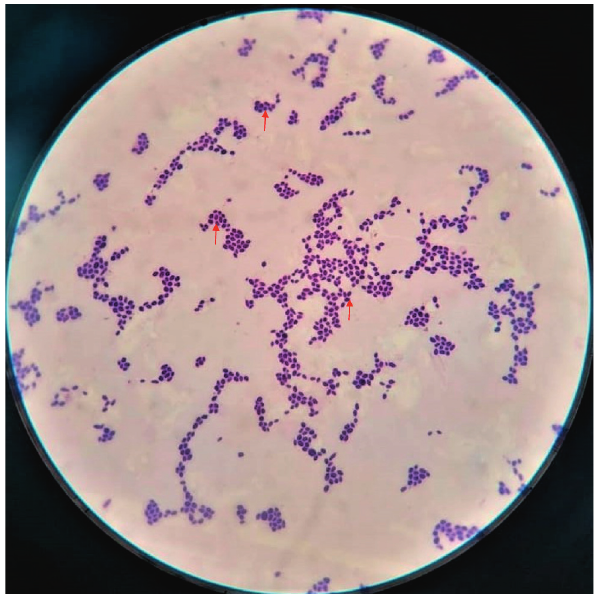
Figure 1: Direct Gram stain from both positive blood culture bottles revealed budding yeast cells (BYCs).